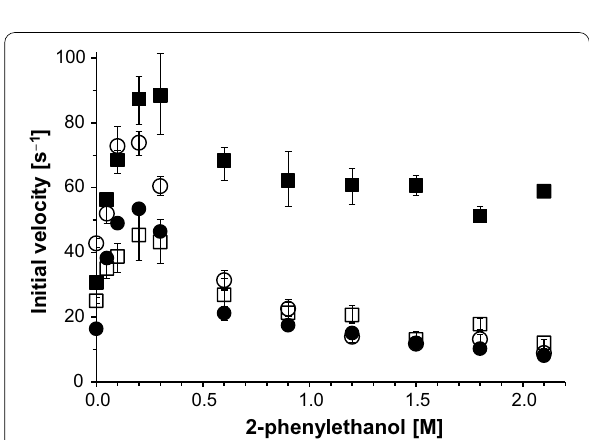
Fig. 4 Initial velocities of transglycosylation reactions with Mc Glc and Pc Glc as catalysts in the presence of 1 or 2 and various concentrations of 2-phenylethanol. The total activities (hydrolysis plus transglycosylation) are shown for 1 ( Mc Glc, ○ ; Pc Glc, □ ) or 2 ( Mc Glc, ● ; Pc Glc, ■ ) as a substrate/glycosyl donor. Reaction conditions: 37 °C, 10% DMSO, 1 mM of compound 1 or 2 mM of 2 , 0.25–1.0 µg mL − 1